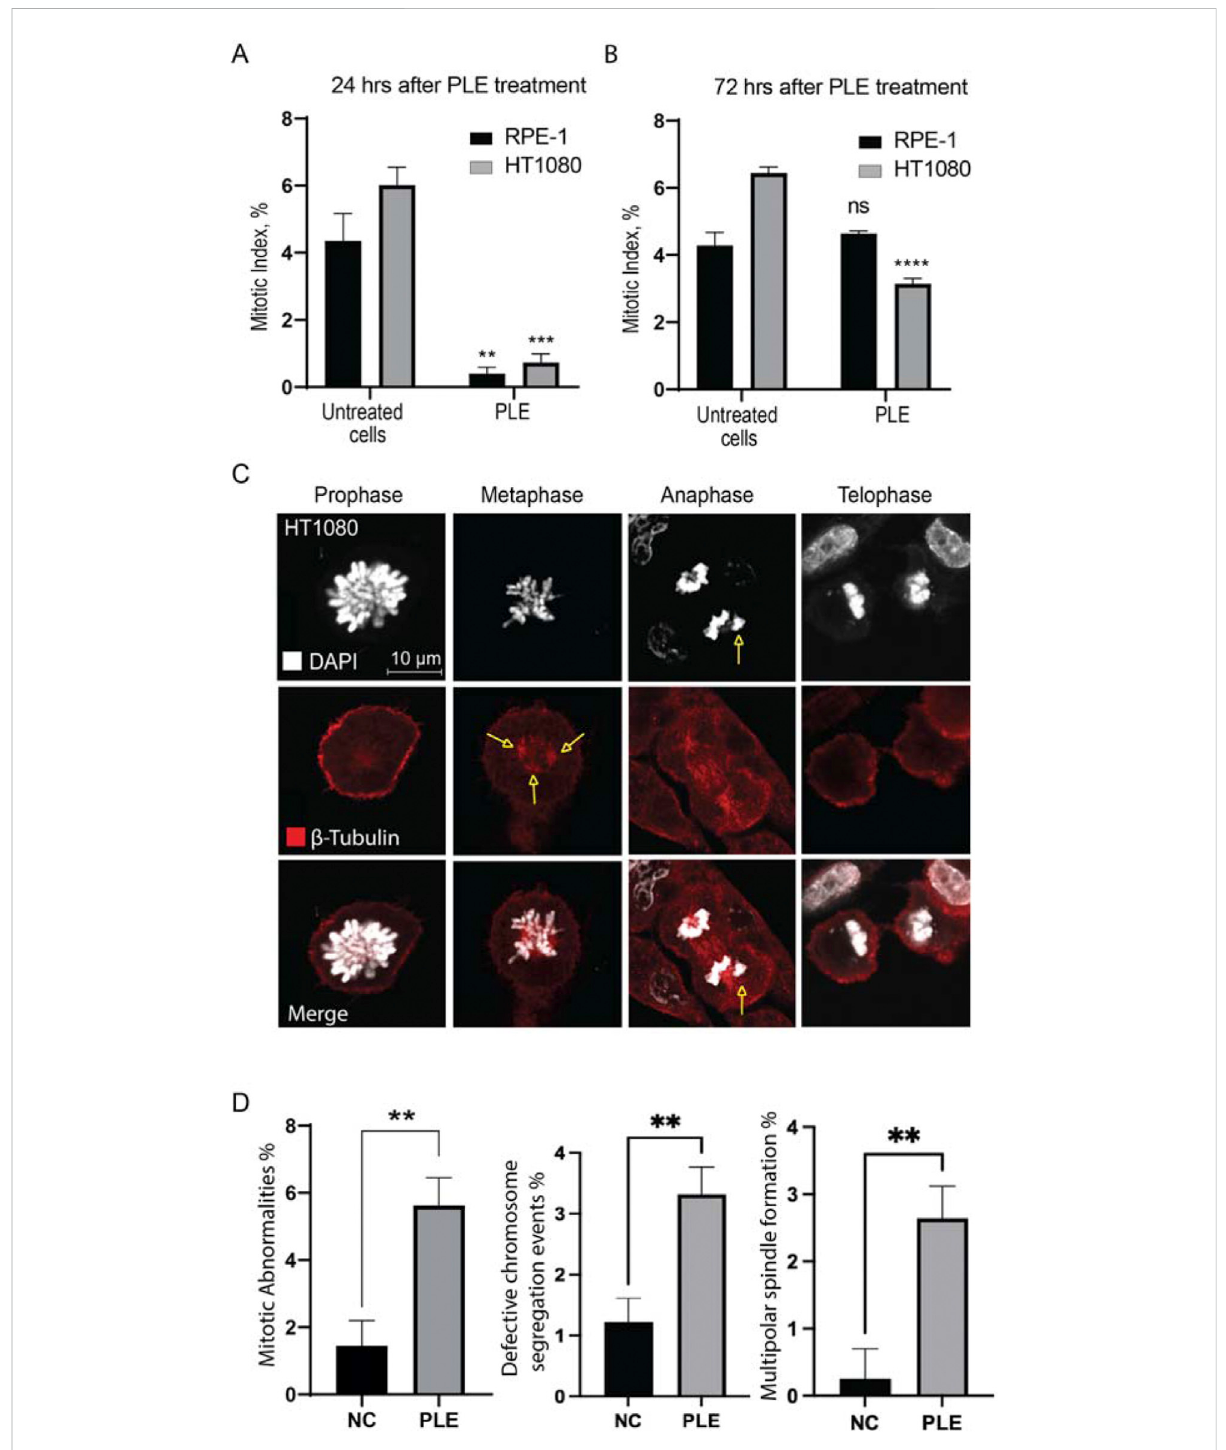
Mitotic index ofHT1080 and RPE-1 cells treated with PLE. (A) The percentage ofmitosis in HT1080 and RPE-1cells24 hafter PLEtreatment. (B) The percentage ofmitosis 72 hafter PLE treatment. (C) Analysis oflocalization of tubulin beta at thedifferent stages of mitosis after PLE treatmentin HT1080 cells. Staining by antibodies against tubulin beta is marked in red and DAPI in white. Yellow arrows point to the observed mitotic abnormalities. (D) Proportion of observed mitotic abnormalities in HT1080 cells. Representative pictures of localization of tubulin beta at the different stages of mitosis in untreated HT1080 cells are shown in Supplementary Figure S4. Between 100 and 150 mitotic events were analyzed. Statistical analysis was performed using 2way ANNOVA, asterisks indicate statistical signi fi cance (** p < 0.01, *** p < 0.001, **** p < 0.0001 relative to the negative control — untreated